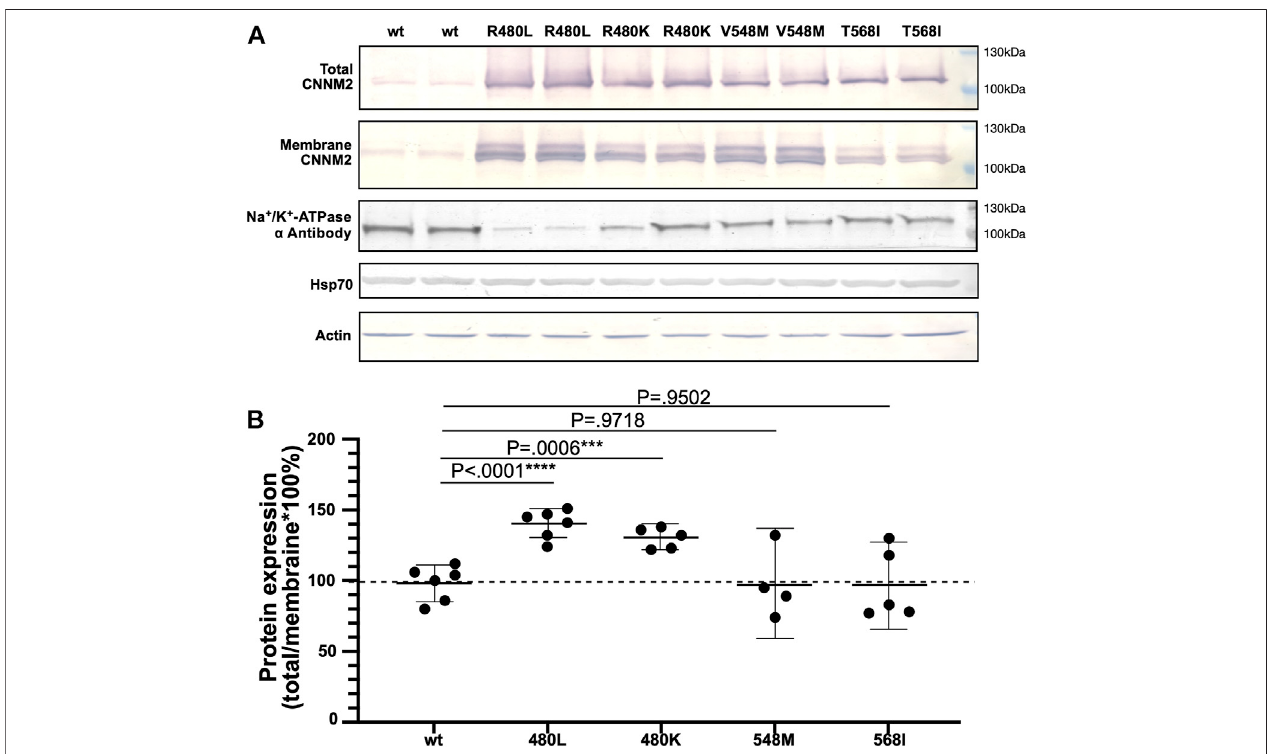
FIGURE 3 | Expression of the mutant CNNM2. (A) mDCT cells were transfected with pcDNA3.1.HA.CNNM2-wild type, pcDNA3.1.HA.CNNM2-R480L, pcDNA3.1.HA.CNNM2-R480L, pcDNA3.1.HA.CNNM2-V548M, and pcDNA3.1.HA.CNNM2-T568I expression constructs. Cells extracts were subjected to western blotanalysisandprobedwithantibodiesagainstCNNM2.Antibodiesto α -actinandHsp70wereforloadingcontrolofmDCTcells. (B) Resultsarerepresentativeofthree independent experiments and show increased membrane expression of CNNM2-R480L and CNNM2-R480K.